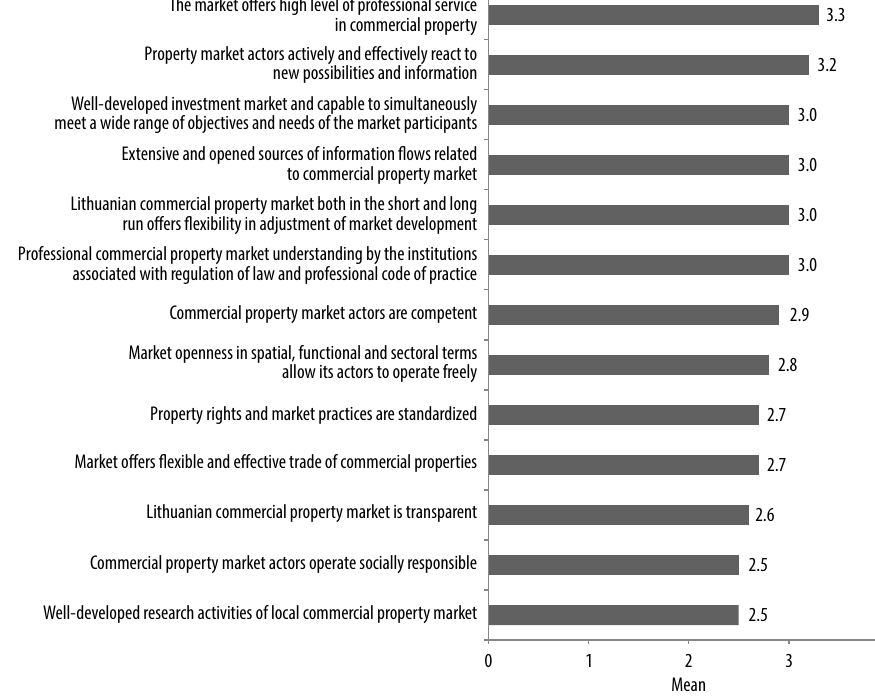
Fig. 4. Mean scores of commercial property market maturity